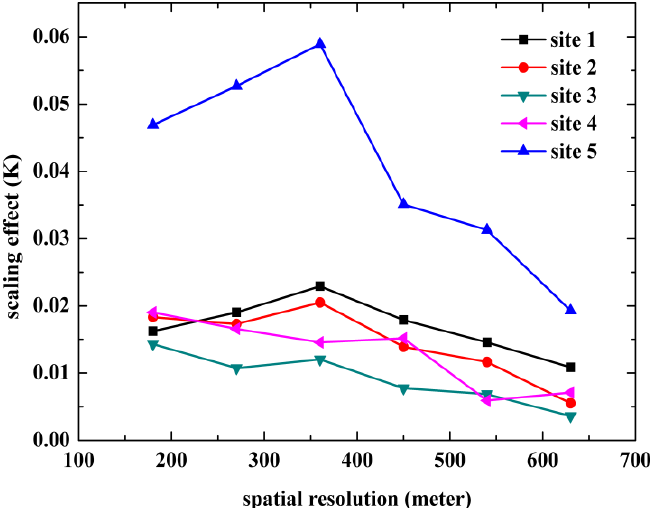
Figure 7. The relationship between the spatial resolution and the LST scaling effect for the ASTER LST data in the five study areas. The distributed LST was derived from Method